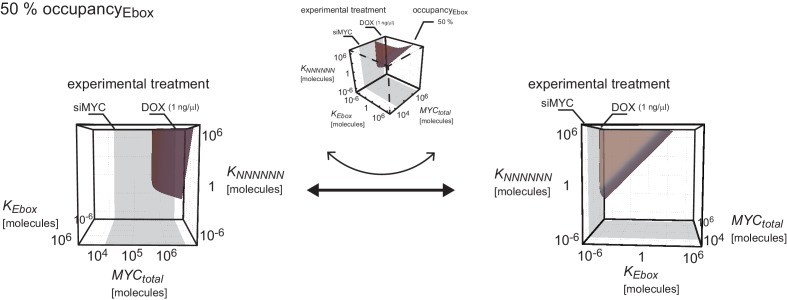
Plot shows surface of occupancyEbox=50% of Appendix 2–figure 1A in two different orientations: rotated into the [MYCtotal]-KEbox -plane and into the KEbox-KNNNNNN -plane.